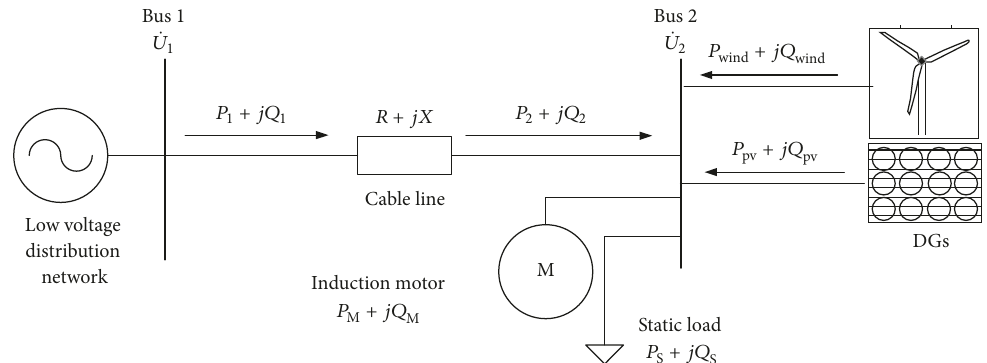
Figure 2: Model of conventional low voltage distribution network integrated with DGs.